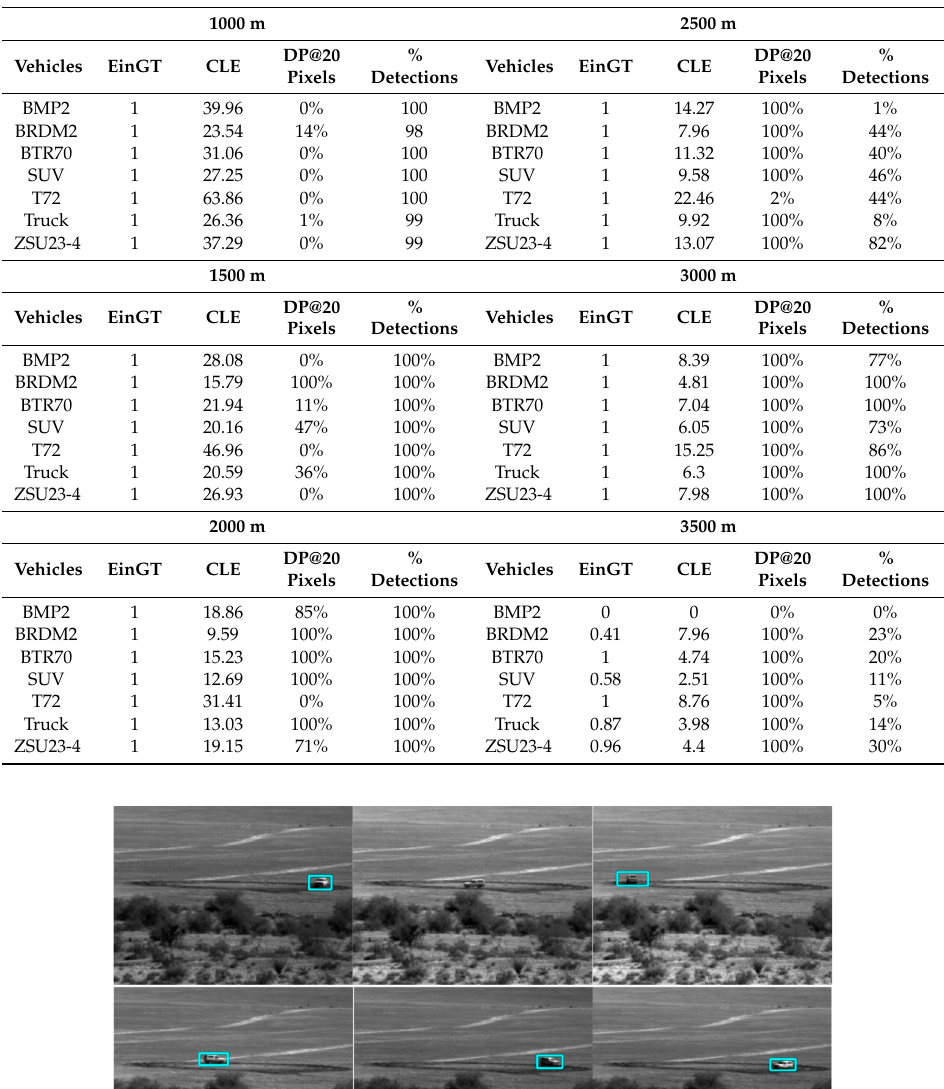
Table 2. Tracking metrics for PCE full (optical videos).